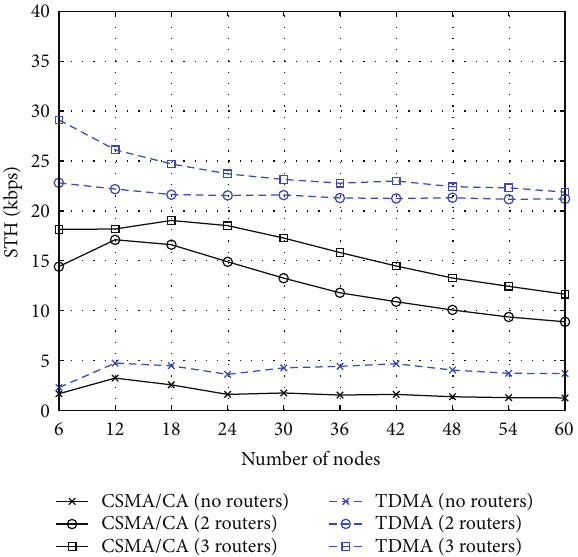
F 10: STH comparison between CSMA/CA and